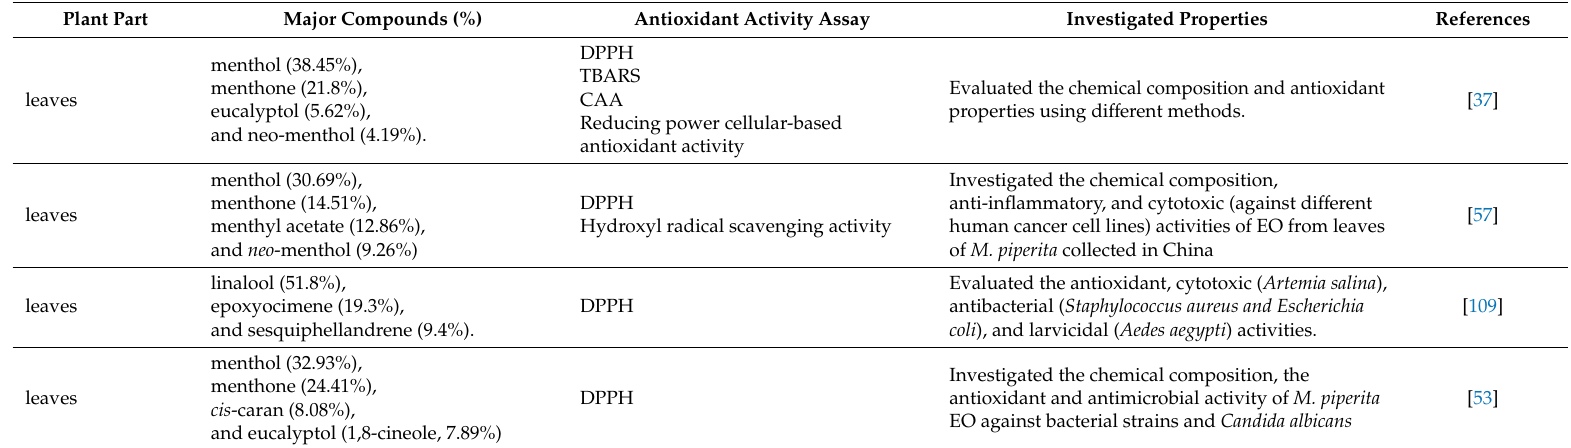
Table 2. Major natural compounds, methodologies applied to determine the antioxidant activity, and the investigated applications of Mentha piperita (Lamiaceae)